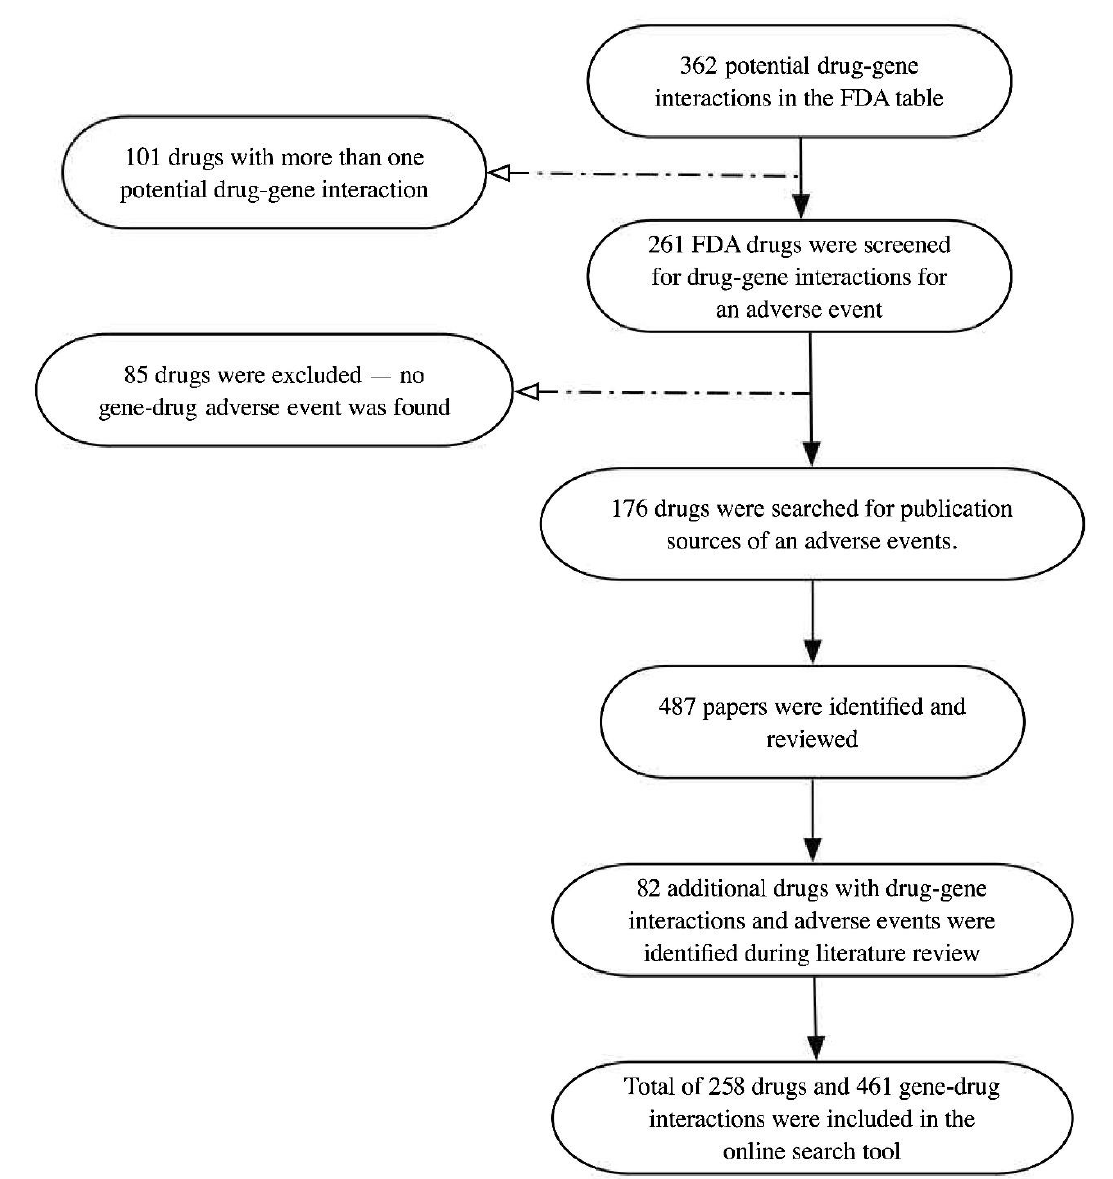
Figure 1. Flow chart of the selection of drugs using the Table of Pharmacogenomic Biomarkers in Drug Labeling by Food and Drug Administration (FDA) and literature review process to identify the drug–gene interactions and potential adverse effects in the different fields of medicine, including perioperative medicine.